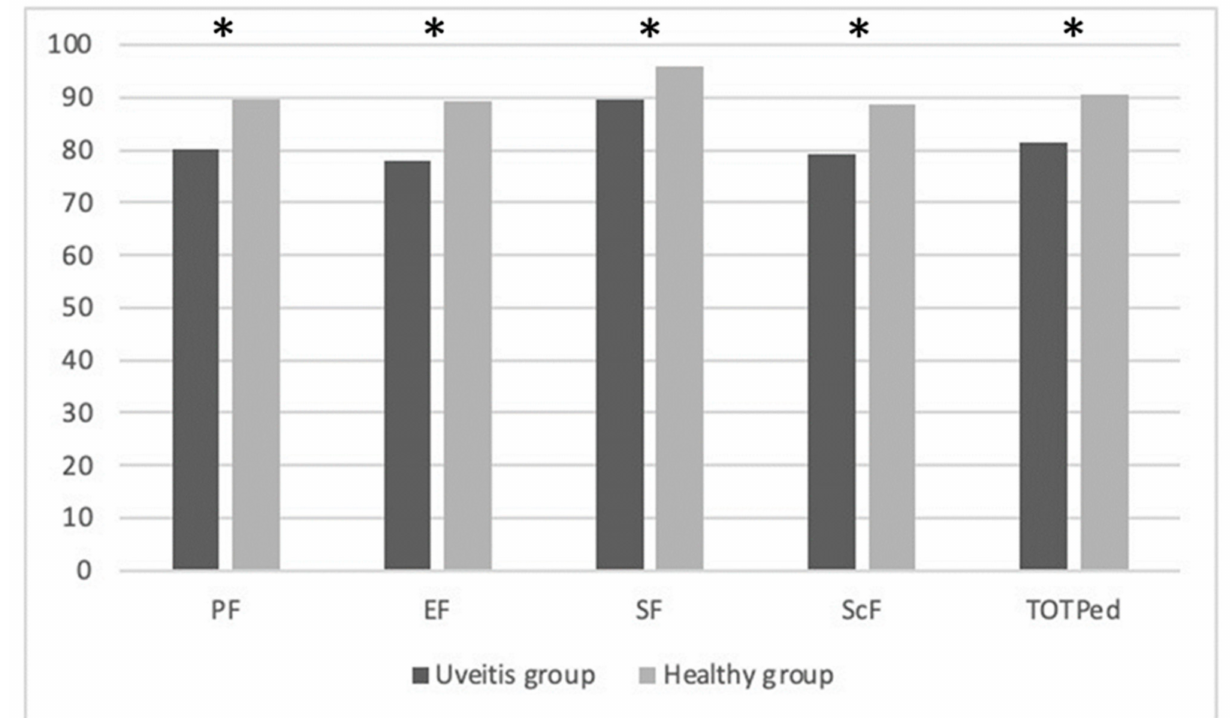
Figure 1. Explained the PedsQL mean scores differences between groups. * significant